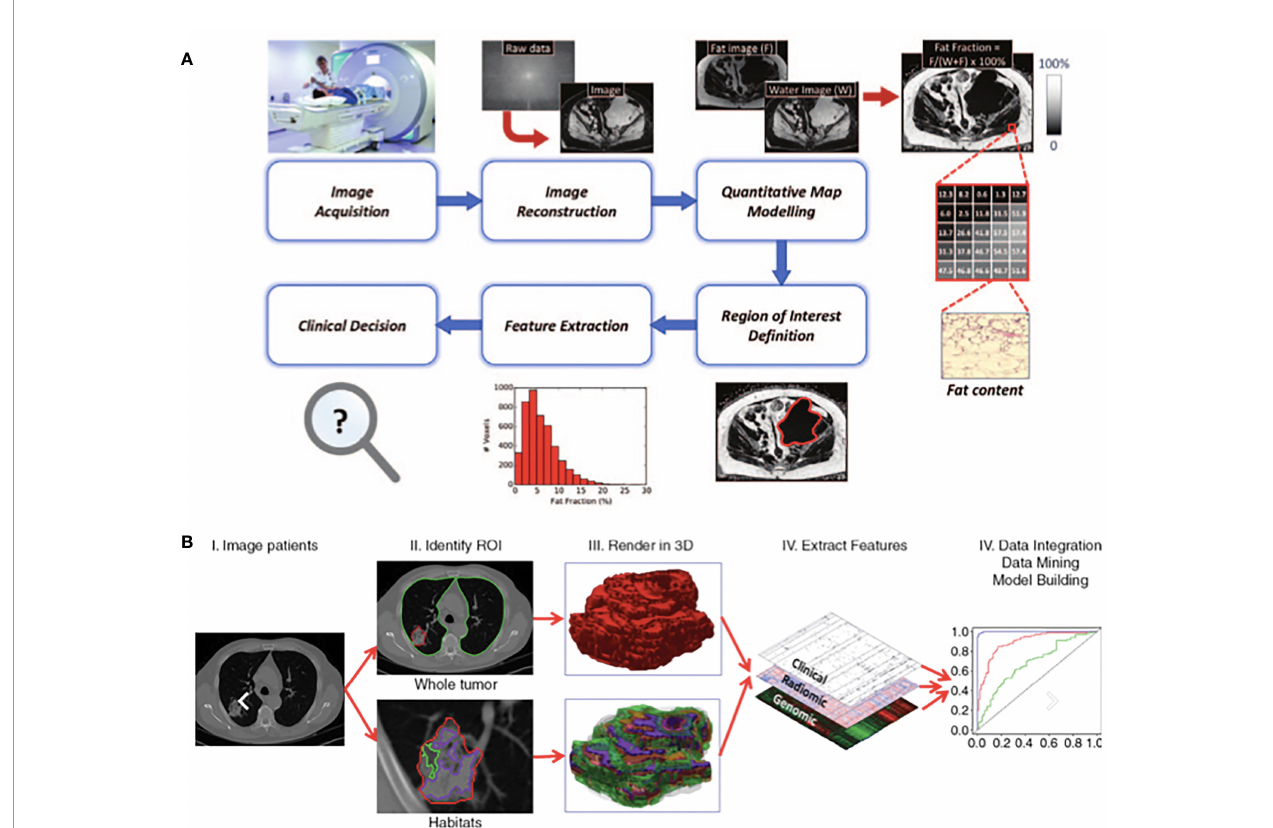
FIGURE 1 | Exemplars of typical quantitative imaging in (A) and radiomic work fl ows in (B) taken from Blackledge et al. (22) and Gillies et al. (24) respectively. (A) Quantitative imaging Involves a detailed process of steps. Following image acquisition and image reconstruction, quantitative maps are developed either by the scanner or of fl ine and these maps differ from the parent images as each voxel has an unit of measurement. Multiple regions of interest are often selected, features extracted accordingly to aid clinical decisions. (B) Radiomics involves a multi-step process. Following acquisition of high quality images, regions of interest and/or habitats are de fi ned. These are reconstructed into 3D. Radiomic features are extracted and models are developed with correlation of these extracted features and pre-de fi ned clinical outcomes of